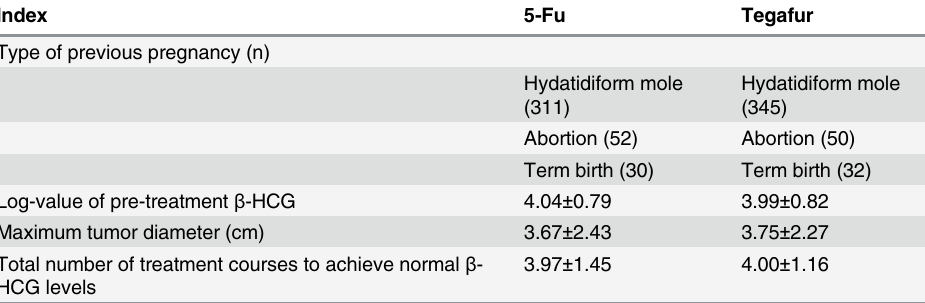
Table 2. Type of previous pregnancy, pre-treatment β -HCG levels, maximum tumor diameter, and the total number of treatment courses to achieve normal β -HCG levels ( x ±